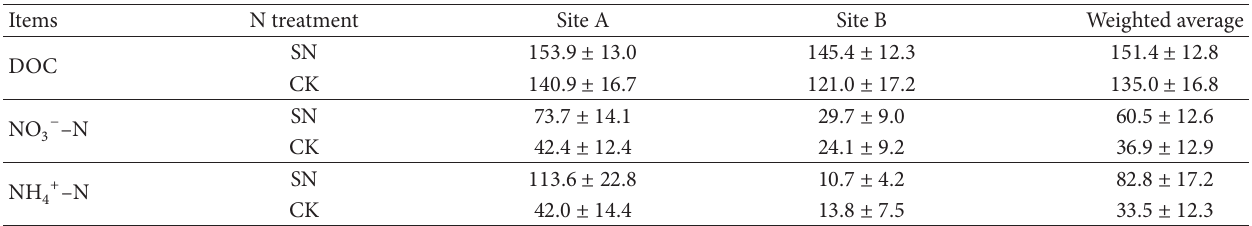
Table 2: Average concentrations (mean ± SE) of soil DOC (mg Ckg −1 ) and IN (mgN kg −1 ) during the experimental period.